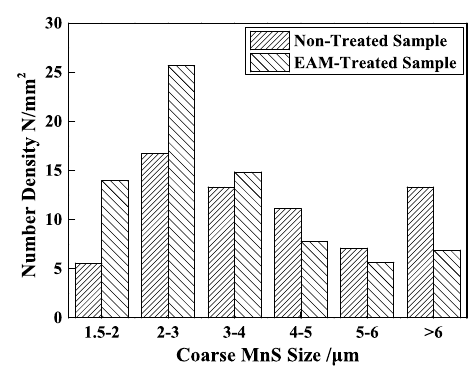
Figure 4: The relationship between coarse MnS size and